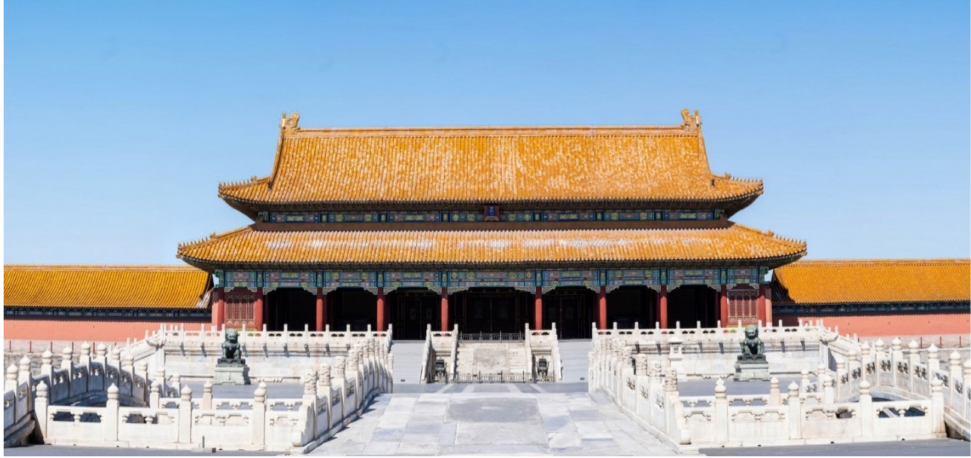
Figure 8. The Gate of Supreme Harmony